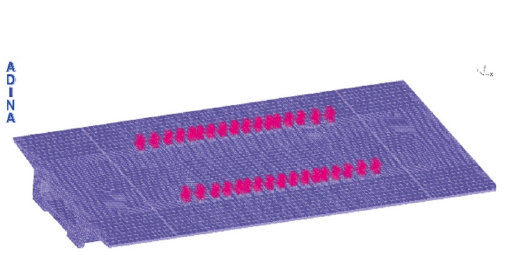
Figure 6: The finite element model of box girder transport.